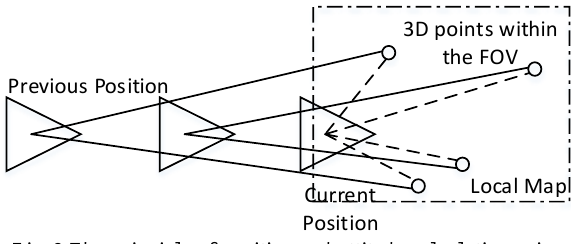
Fig. 3 The principle of position and attitude calculation using local map.